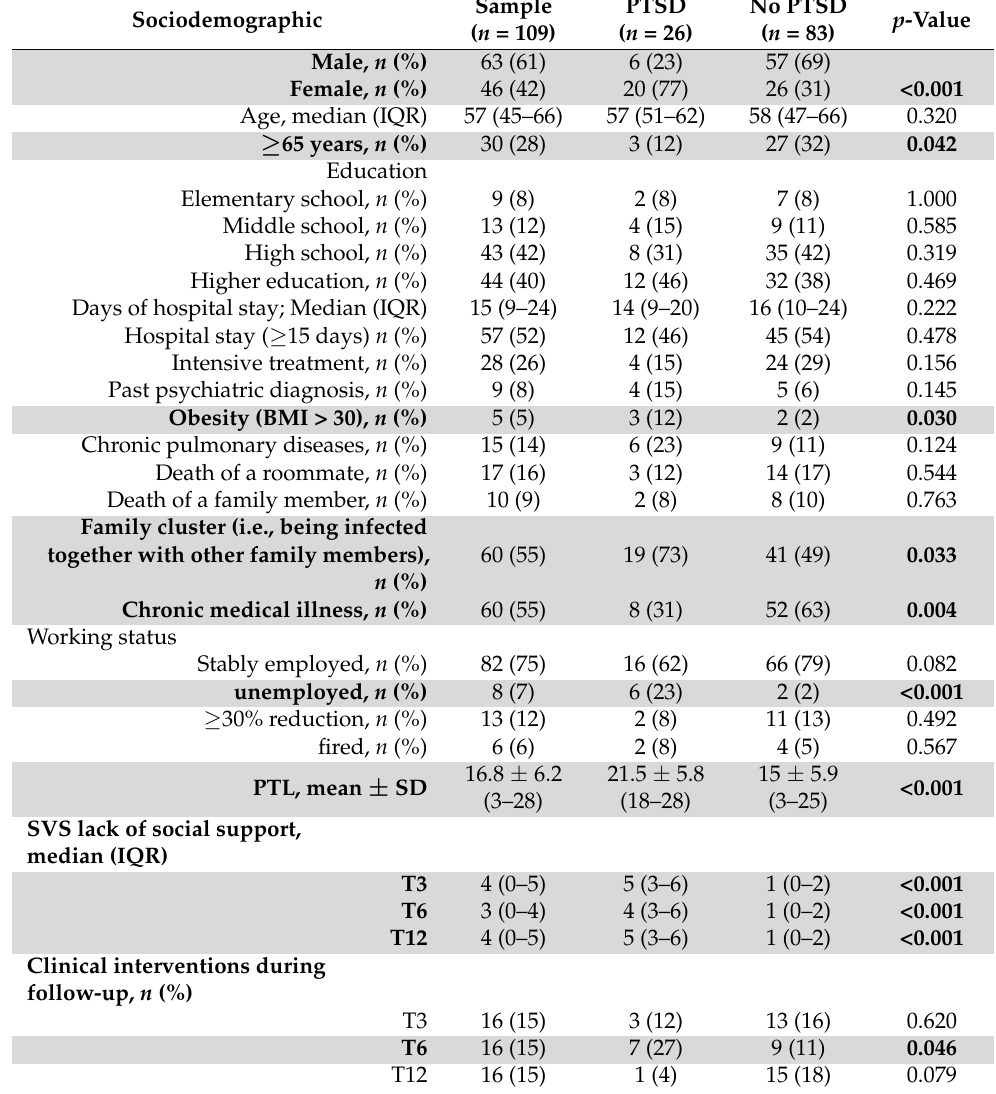
Table 1. Demographic, clinical and treatment characteristics in the whole sample and in the 12-month period PTSD subgroups.